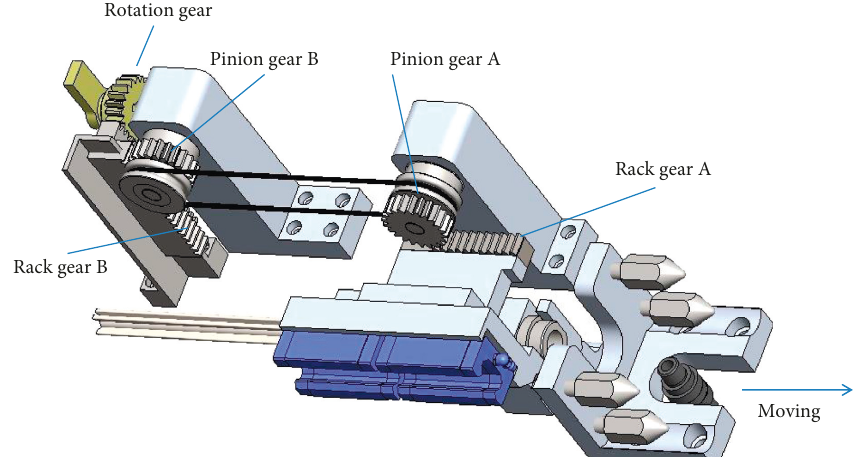
Figure 15: Rod-cut feeding